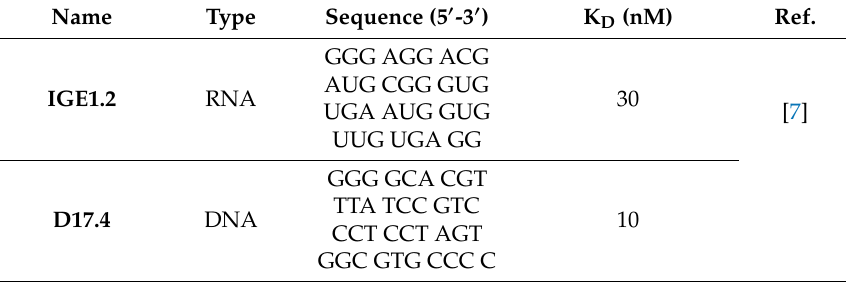
Table 8. The most widely used IgE selective